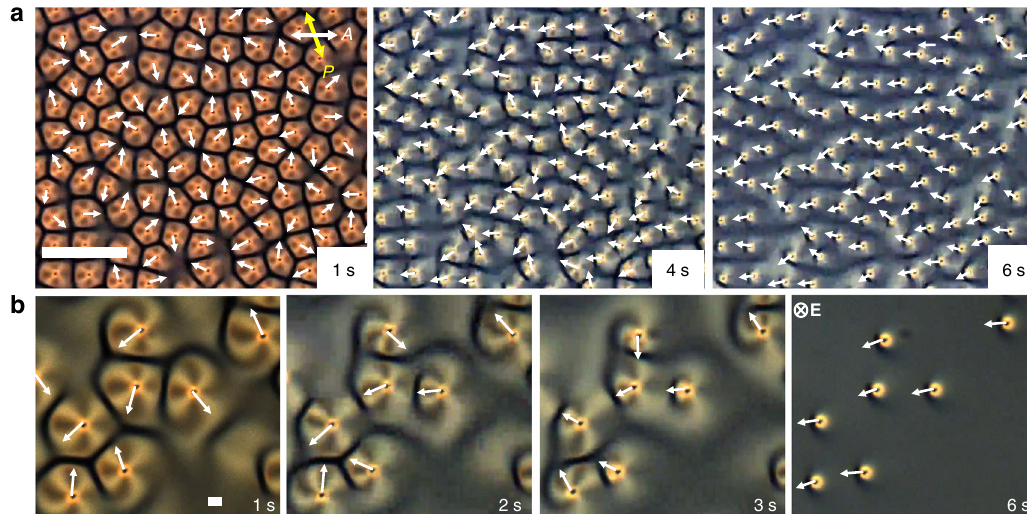
Fig. 3 Temporal evolution of skyrmion velocity vector orientations. This analysis is done at the onset of the ordering transition corresponding to Fig. 4d of the main text. a , b Polarizing micrographs of a a higher number density region and b a lower number density region within the same sample at elapsed times marked on the images. White arrows point along the directions of skyrmion motion, representing the velocity unit vectors, v i . The applied voltage is U = 3.5 V. The scale bars are a 100 µ m and b 10 µ m. Double arrows denote uncrossed polarizer and analyzer orientations and direction of voltage application in marked in the last frame of b . The chiral LC is the nematic host ZLI-2806 doped with CB-15